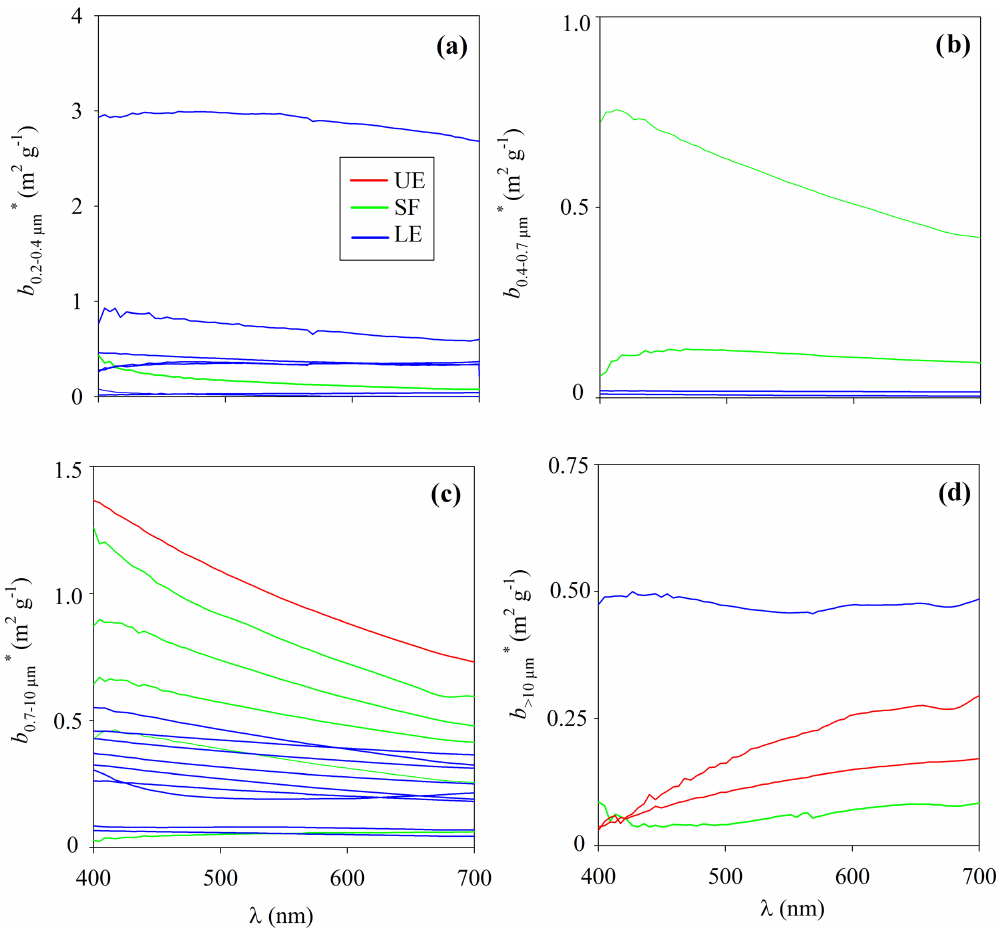
Figure 4. Spectral variation of mass-specific scattering coefficients for different size classes of suspended particulates. Size classes and color coding of symbols idem as Fig. 3. Curves presenting negative values at some wavelengths are not depicted.